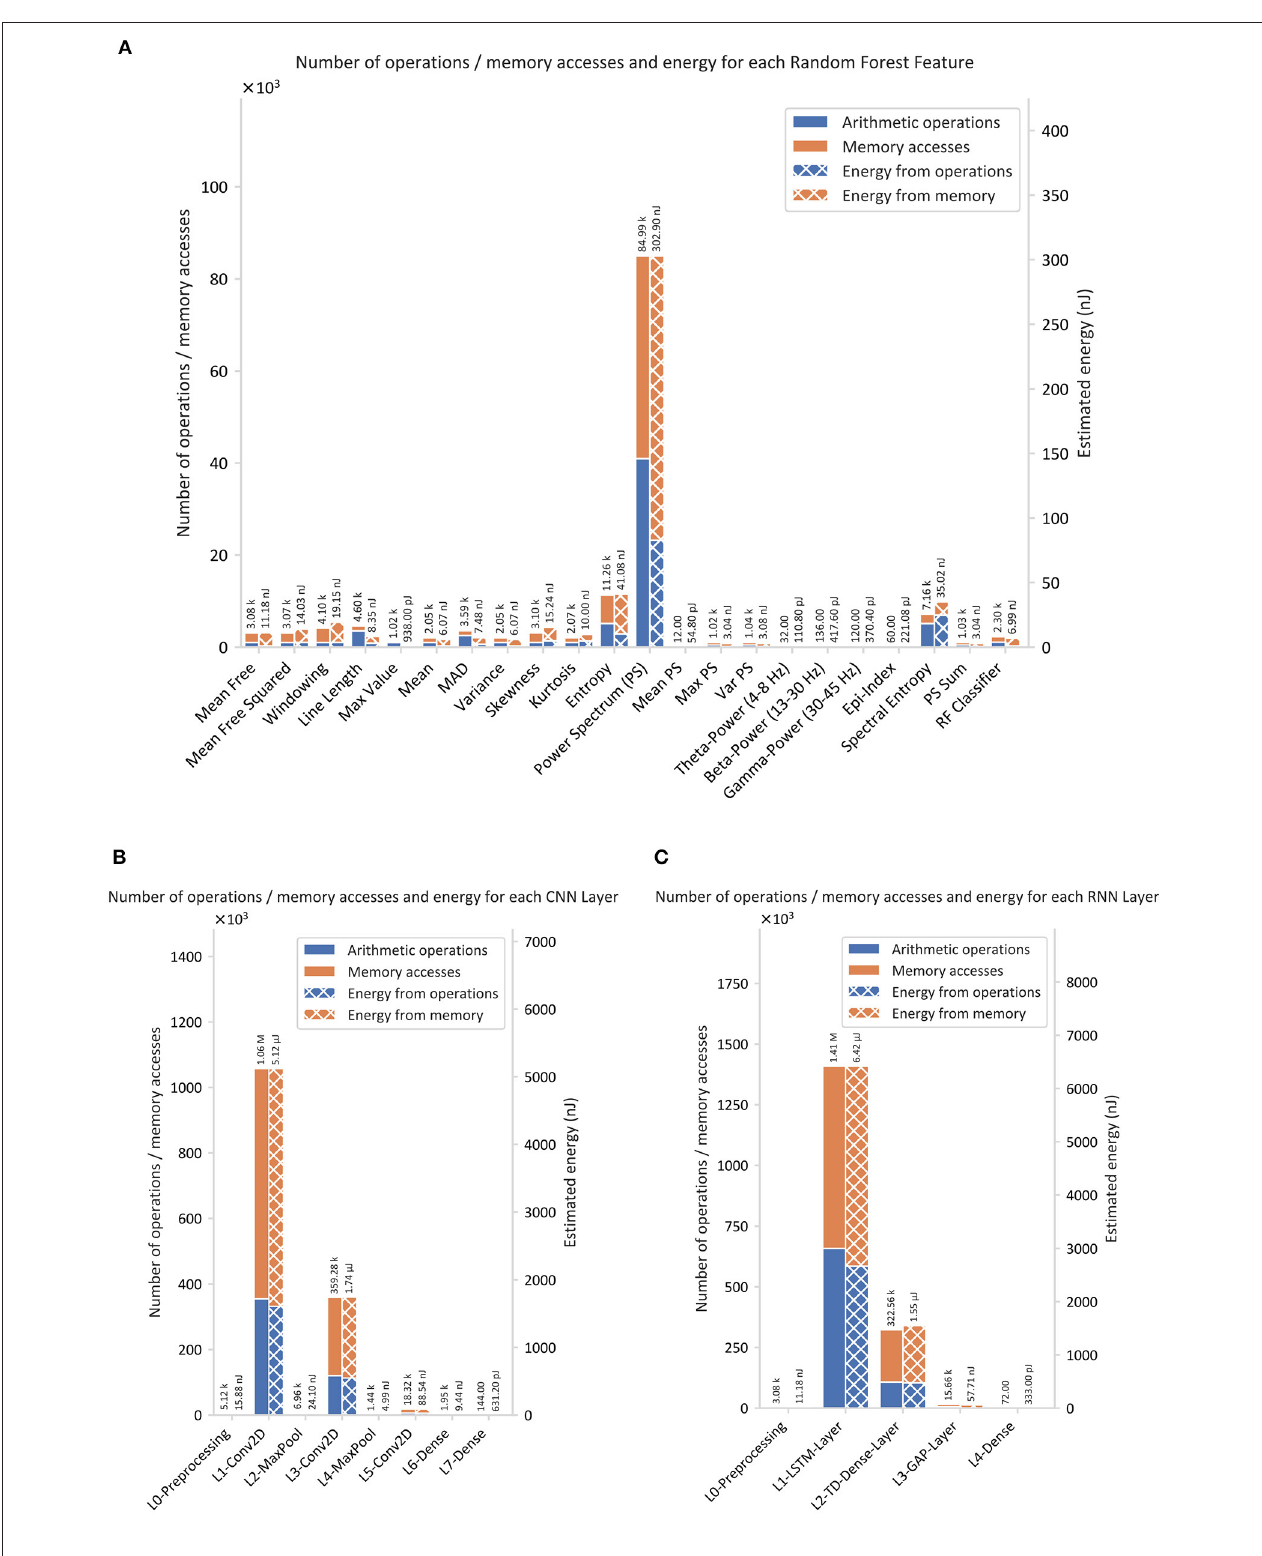
FIGURE 6 | Estimated number of arithmetic operations, memory accesses, and energy using the proposed method: (A) RF, (B) CNN, and (C) RNN.